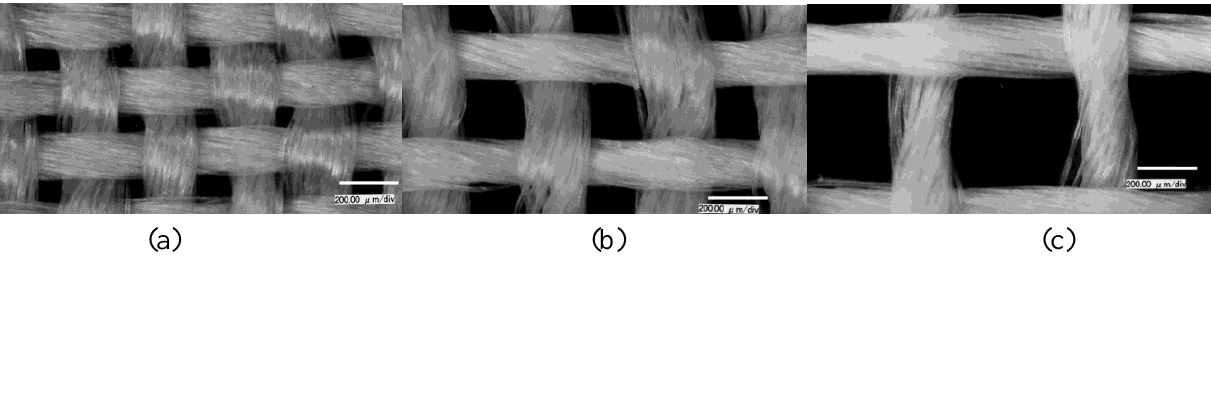
Figure 4. Macroscopic appearance of 3D fabricated scaffolds from the chitosan-based HA hybrid polymer fibers: ( a ) 100 μm pore size, ( b ) 200 μm pore size, and ( c ) 400 μm pore size